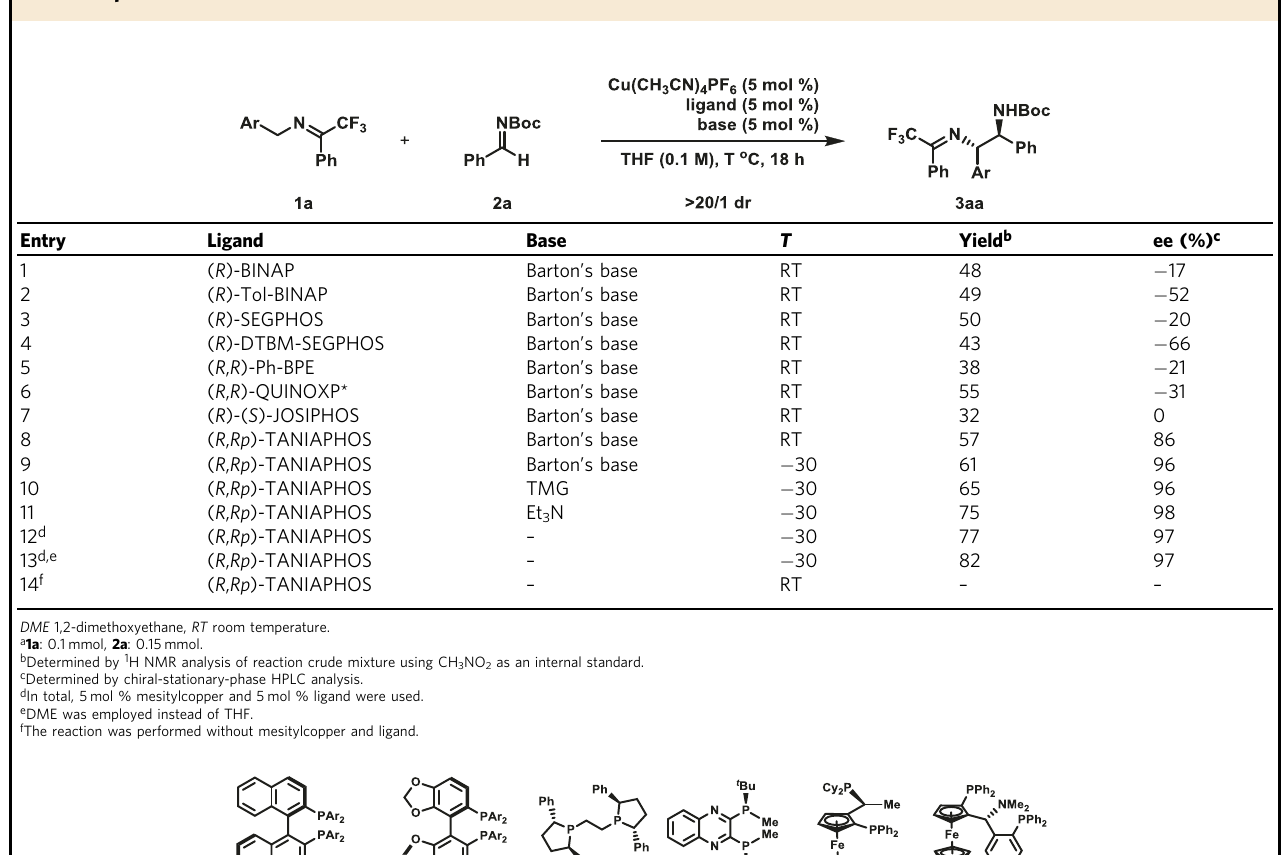
Table 1 Optimization of reaction conditions a